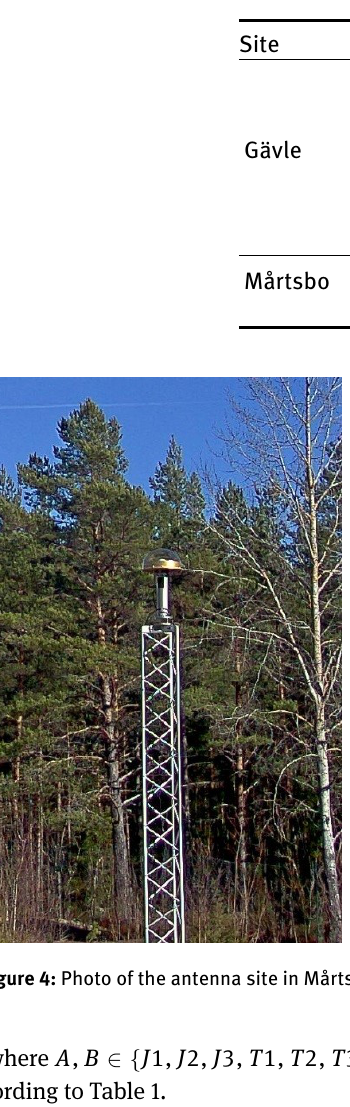
Table 1: Equipment used in the zero-baseline experiment